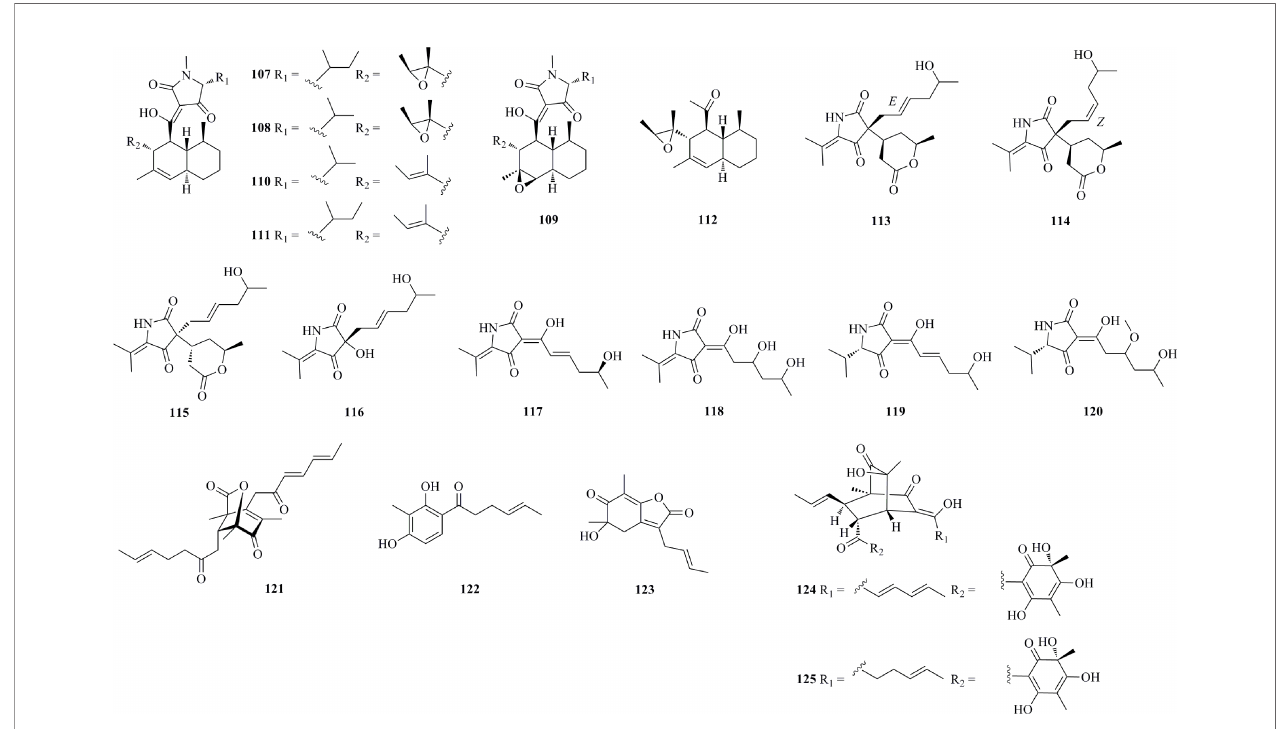
FIGURE 7 | Tetramic acid and sorbicillinoid derivatives isolated from deep-sea fungi ( 107 − 125 ).